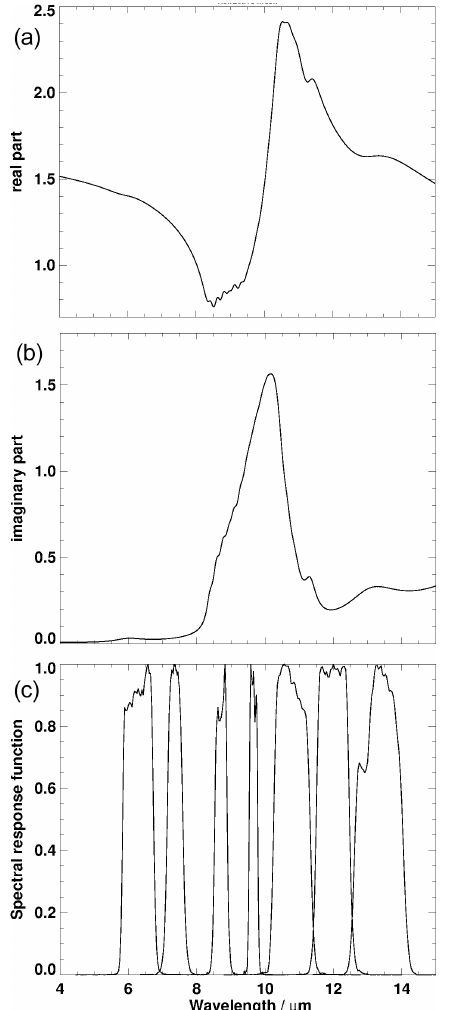
Figure B2. Real and imaginary part of the refractive index m of Eyjafjallajökull ash ( (a) and (b) ) and spectral response functions of MSG2/SEVIRI2 (c)